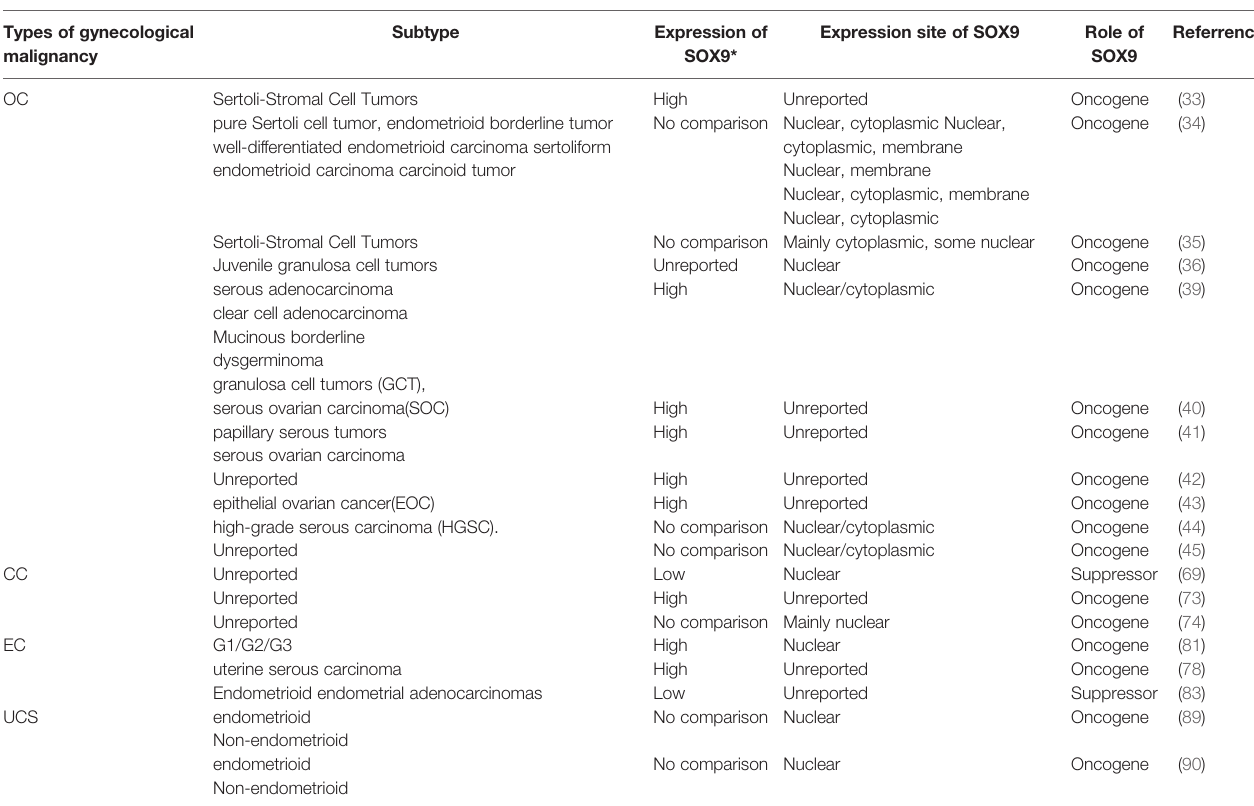
TABLE 2 | The expression of SOX9 in gynecological malignancy.